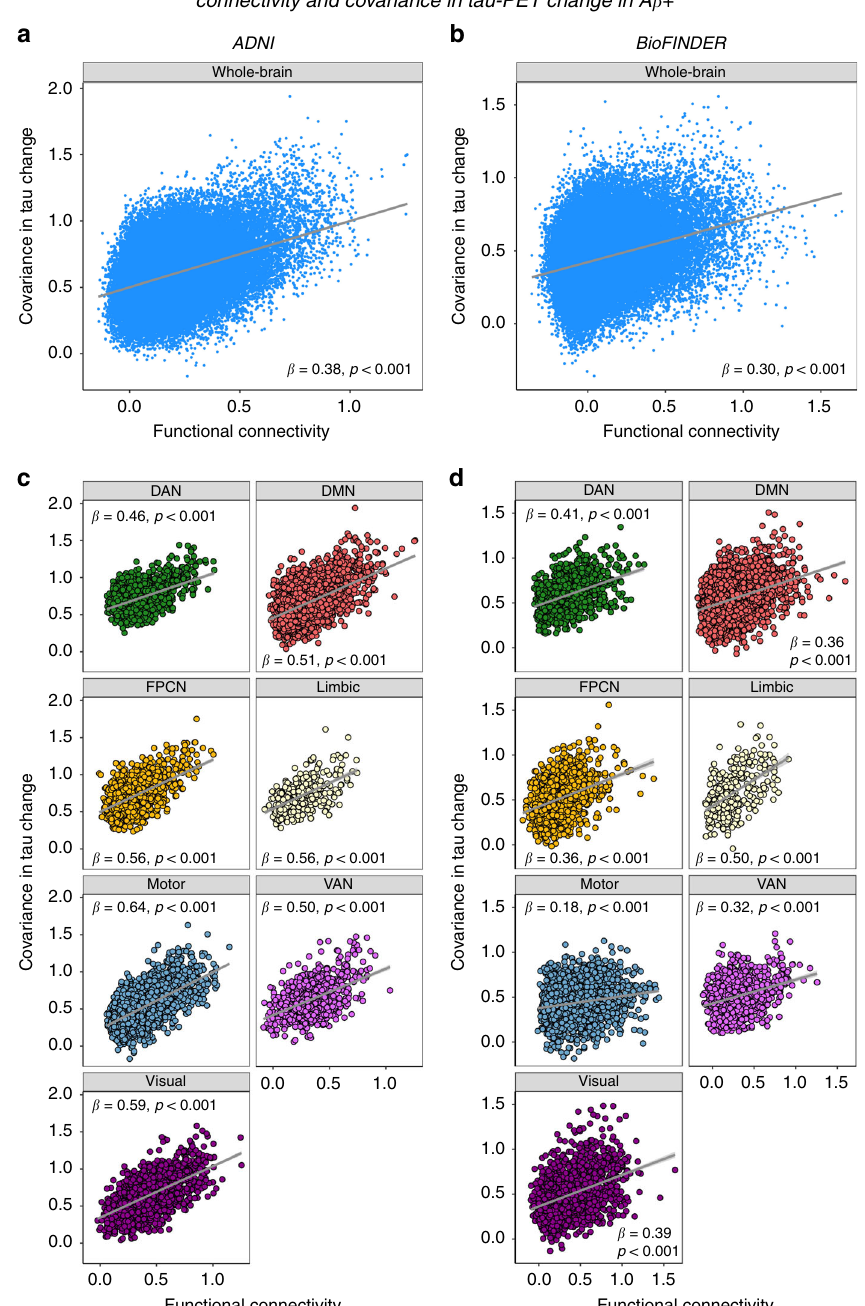
Fig. 4 Association between functional connectivity and covariance in tau-PET change. Scatterplots illustrating the association between group-average functional connectivity and covariance in tau-PET change in the A β + groups of the ADNI ( N = 53) and BioFINDER ( N = 41) samples, for the whole brain ( a , b ) or for the seven canonical brain networks ( c , d ). Standardized β - and p -values were derived from linear regression. Source data are provided in a Source data fi